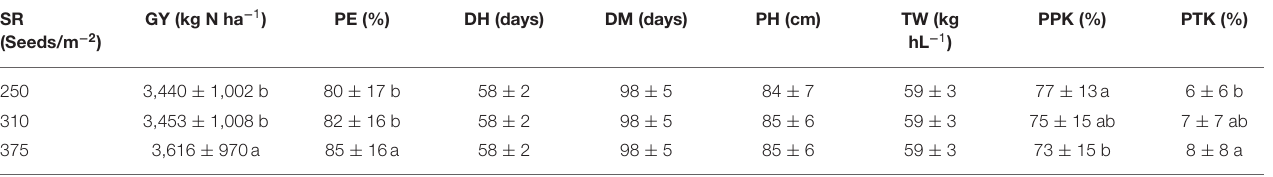
TABLE 11 | Effect of seeding200mm][4mm]Q21 rate on grain yield and seed quality across all locations and years. SR (Seeds/m − 2 )